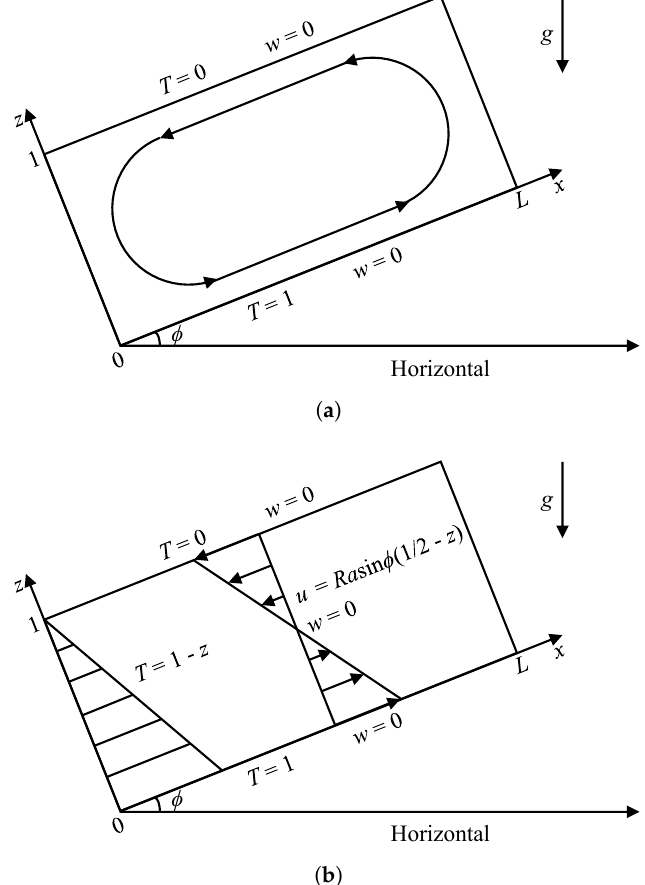
Figure 1. Dimensionless geometry and background/basic state for 2D convection in inclined Rayleigh–Darcy domains. ( a ) Closed domain; ( b ) L -periodic domain. x and z are the wall-parallel and wall-normal coordinates, respectively, and g is the (dimensional) acceleration of gravity. For φ > 0 ◦ , the basic-state temperature field (realized in the absence of convection) varies only in z , as in the horizontal case ( φ = 0 ◦ ). The basic-state velocity field is nonzero, however, with the background shear flow strengthening as the inclination angle φ is increased. The flow in ( a ) represents the basic unicellular shear flow observed in experiments in a closed domain. In an infinitely extended layer (i.e., L → ∞ ), the unicellular base state becomes x -independent and reduces to a laminar unidirectional shear flow, as shown in ( b